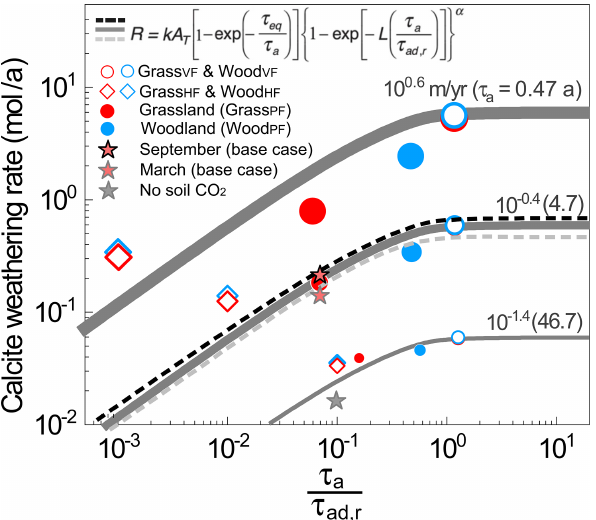
Figure 6. Calcite weathering rate as a function of the reactive time ratio τ a , a proxy of the fraction of the older, reactive water com- τ ad,r pared to the total water fluxes. Symbols are rates from numerical experiments. Gray lines are predictions from the rate law equation at α = 0 . 8 (Wen and Li, 2018). Large to small dots and thick to thin lines are for infiltration rates from 10 0 . 6 to 10 − 1 . 4 m/a. The red filled stars represent the monthly rates in September (highest soil CO 2 ) and March (lowest soil CO 2 ) in the base case at 10 − 0 . 4 (0.37)m/a; the black to gray dashed lines represent predictions with increasing soil CO 2 level (i.e., larger τ eq ) from Eq. (1). The gray filled star is for the case without soil CO 2 . At any specific infiltra- tion rate or τ a , the VF and HF cases bracket the two ends, whereas the PF cases fall in between. The Wood PF case with deeper roots ratios), enhanced the CO 2 –water–calcite contact (i.e., larger τ a τ ad,r leading to higher calcite weathering rates compared to grasslands. The differences of weathering rates induced by different soil CO 2 level were relatively small compared to those hydrological changes induced by rooting